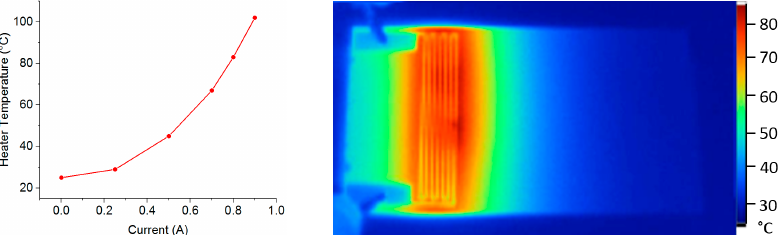
Figure 1. Heating curve and IR image of screen printed silver heater (steady state temperature distribution at a heating power of 20 W; the sensor temperature is 80 °C. The temperature distribution is virtually uniform in the sensor area. The meander like heater is visible due to its much lower emission coefficient compared to organic